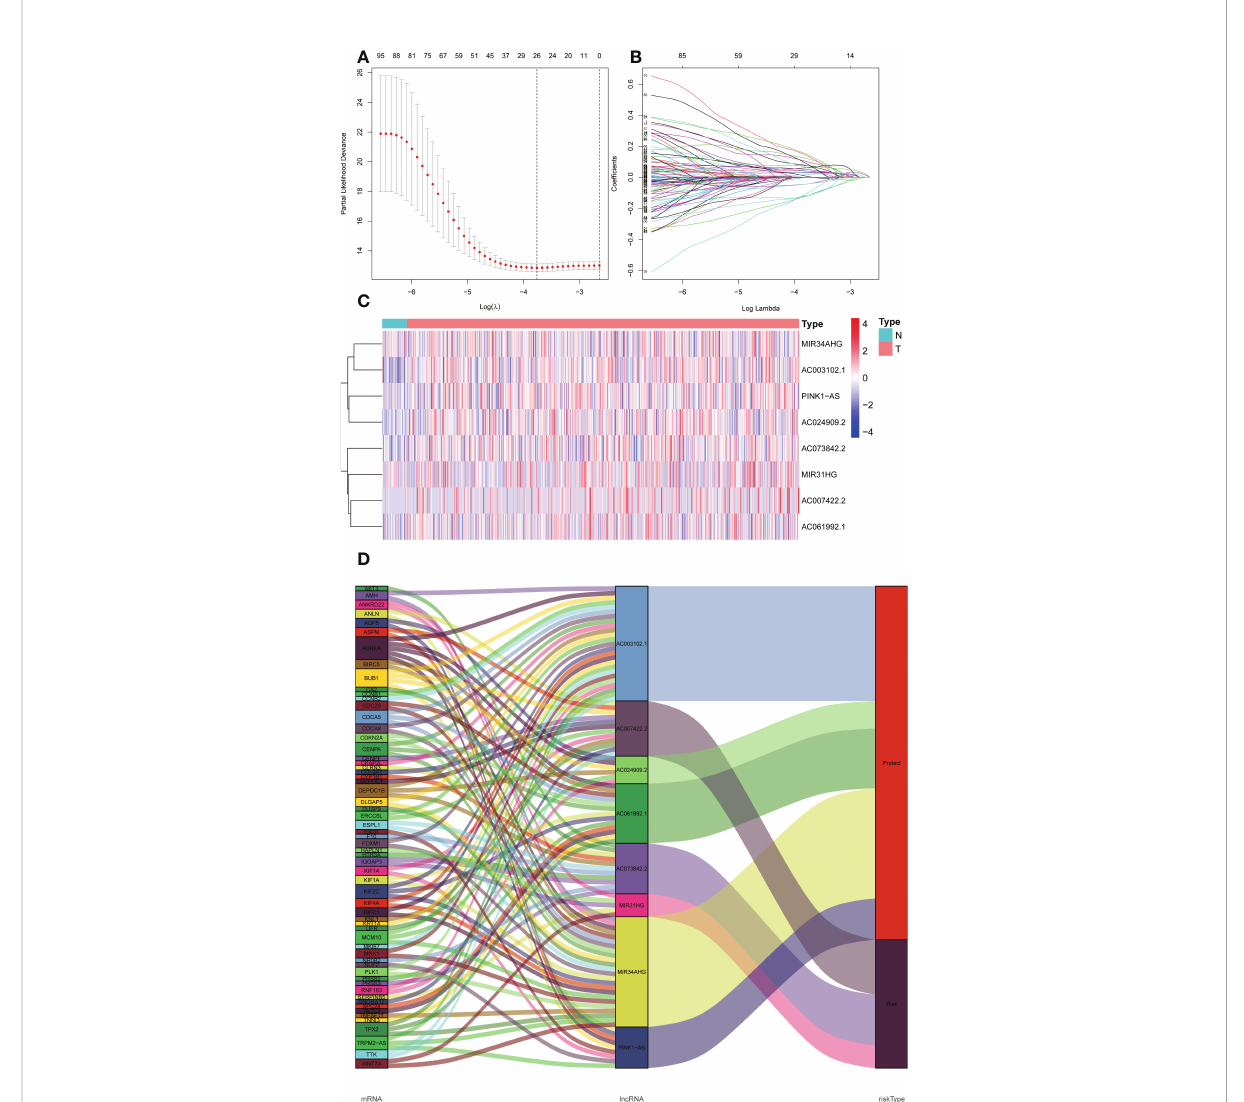
FIGURE 2 The expression levels and lncRNA-mRNA network of eight endoplasmic reticulum stress -related lncRNAs in the predictive signature. (A, B) Lasson regression establishes signature and divides TCGA dataset into training set and validation set. (C) The heatmap of expression levels with eight endoplasmic reticulum stress -related lncRNAs in UCEC and normal tissues. (D) Sankey diagram of prognostic endoplasmic reticulum stress -related lncRNAs. lncRNAs, long noncoding RNAs; UCEC, Uterine Corpus Endometrial Carcinoma; T, tumor; N,